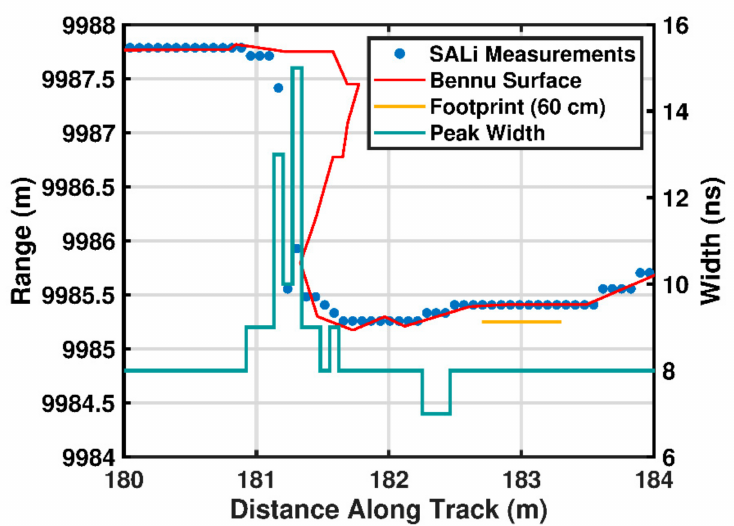
Figure 16. A select region of the track exhibiting high range residuals. The blue markers and red line are the same as in Figure 14 and denote the SALi retrieved range and Bennu ground track from the shape model, respectively. The gold line denotes the size of the SALi footprint on the surface for the measurement at 183 m along the track. As the results are plotted as a function of range as measured by the lidar the Bennu surface normal points down in this